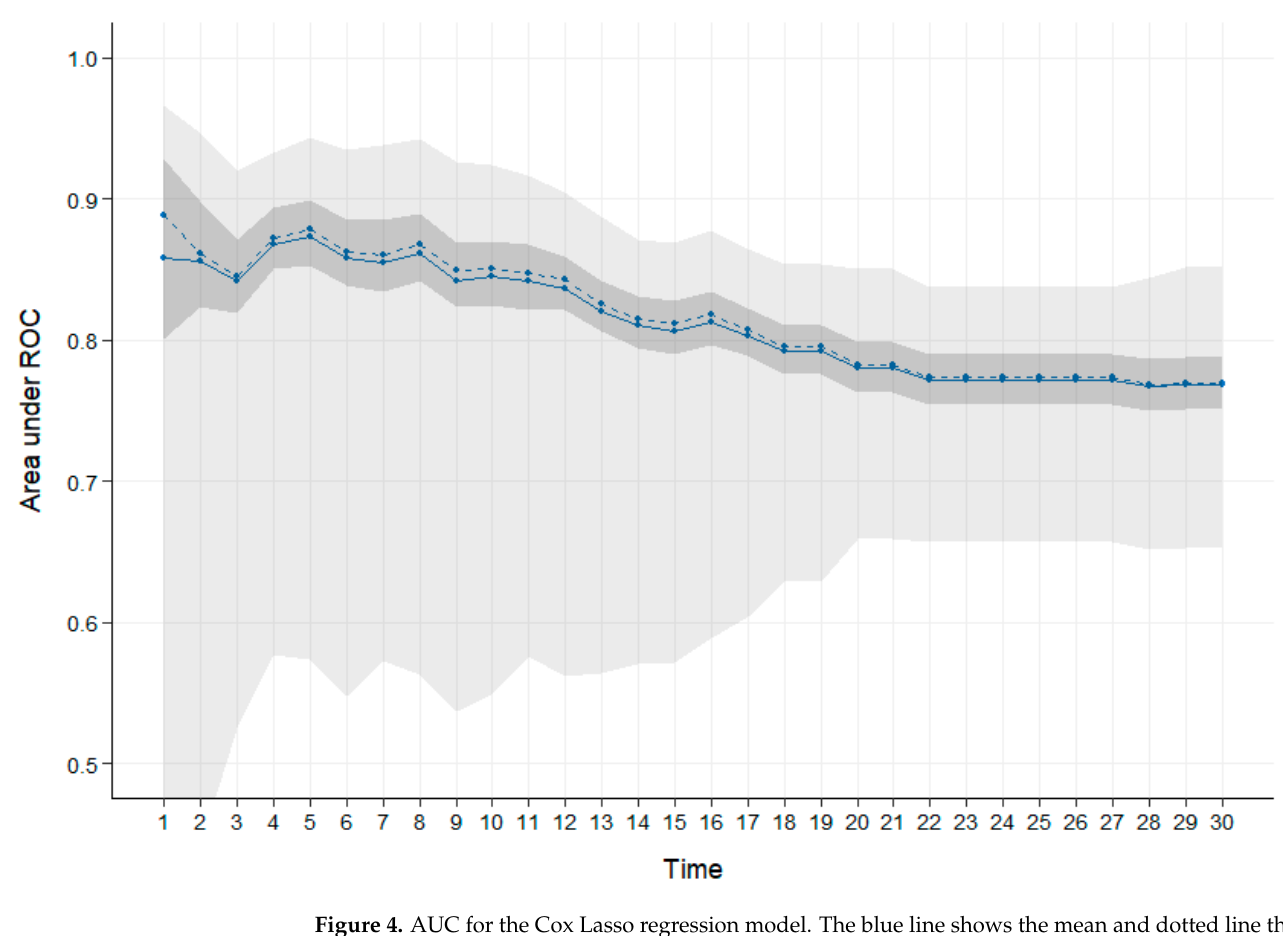
Figure 4. AUC for the Cox Lasso regression model. The blue line shows the mean and dotted line the median. The dark grey shows the confidence interval, and the light grey shows the minimum and maximum values.